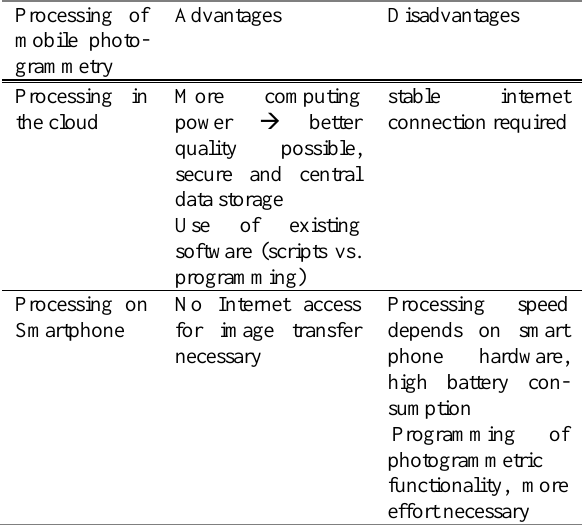
Table 1: Pros and cons of mobile photogrammetric image processing on smartphones vs. in the cloud Processing of